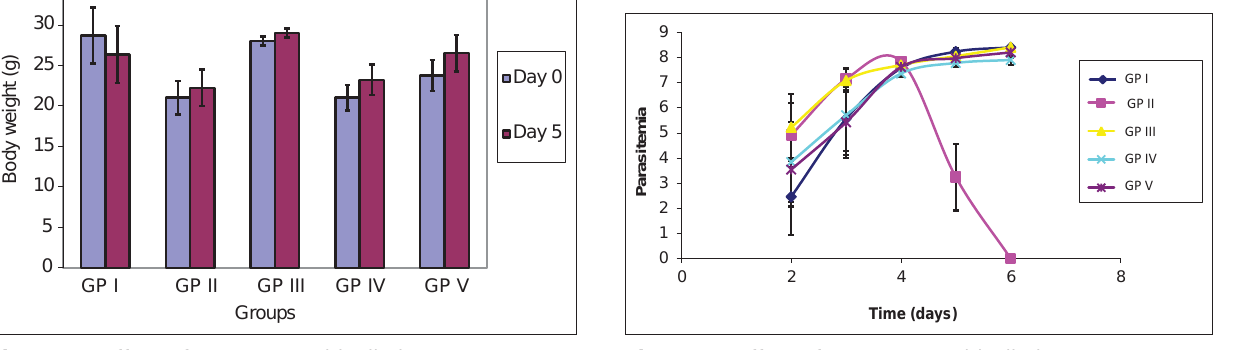
Figure-3: Effect of treatments with diminazene aceturate and ginger extract on the level of parasitaemia in mice experimentally infected with Trypanosoma brucei brucei